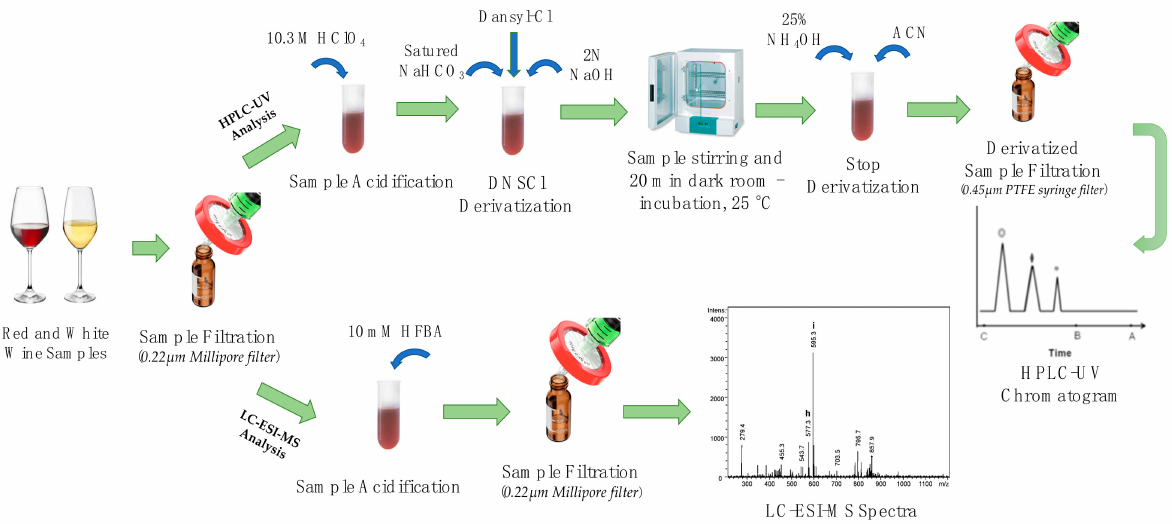
Figure 2. Scheme of biogenic amines determination in wine samples by HPLC-UV and LC-ESI-MS